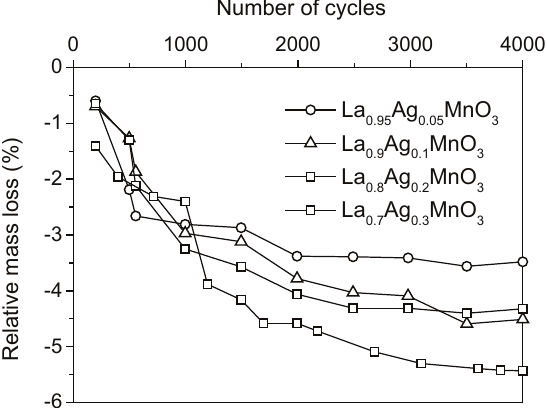
Figure 11. Influence of La substitution by Ag on the resistance of washcoated La catalysts to 4000 cycles of heating to 1000 °C and rapid cooling to room